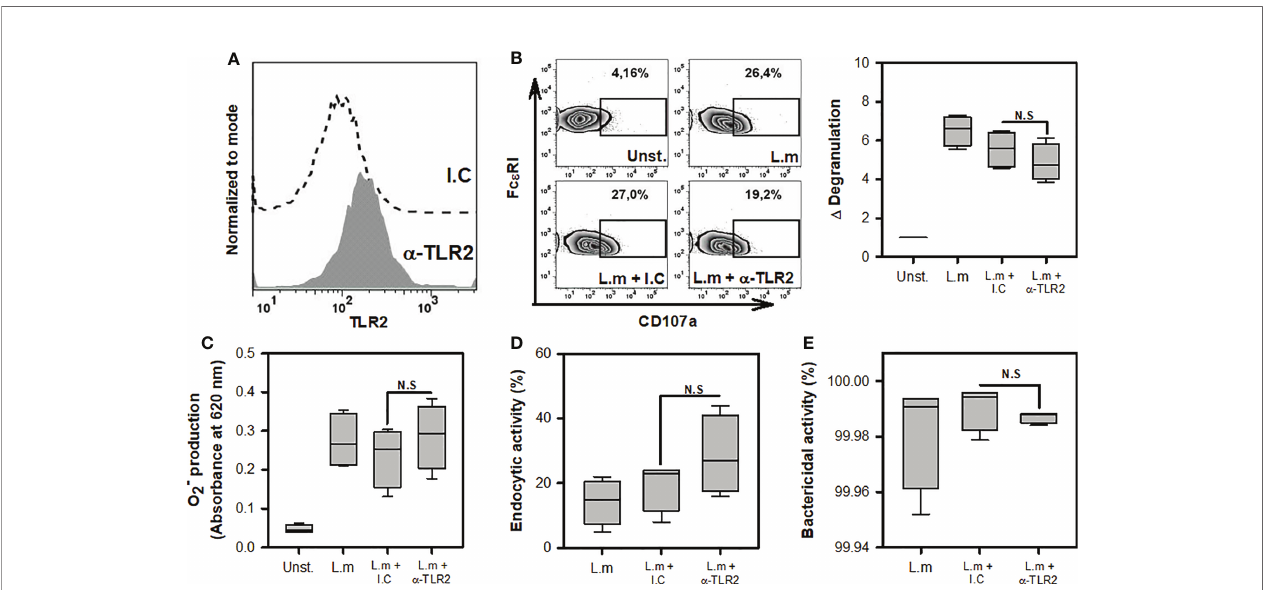
FIGURE 4 | Mast cell degranulation, ROS production, endocytosis and clearance of Listeria monocytogenes are TLR2-independent. (A) . 2.5x10 5 BMMC were marked with anti-TLR2-biotin (1 m g/0.1 mL) or biotinylated isotype control (I.C) (1 m g/0.1 mL) and stained with streptavidin-APC. Staining was evaluated by fl ow cytometry. (B) 2.5x10 5 BMMC/0.25 mL of complete medium were preincubated with anti-TLR2 for 30 minutes and then were stimulated with L.m (MOI 100:1) for 90 minutes. BMMC degranulation was determined by fl ow cytometry. Left panel shows representative zebra-plots. Right panel shows the fold change in